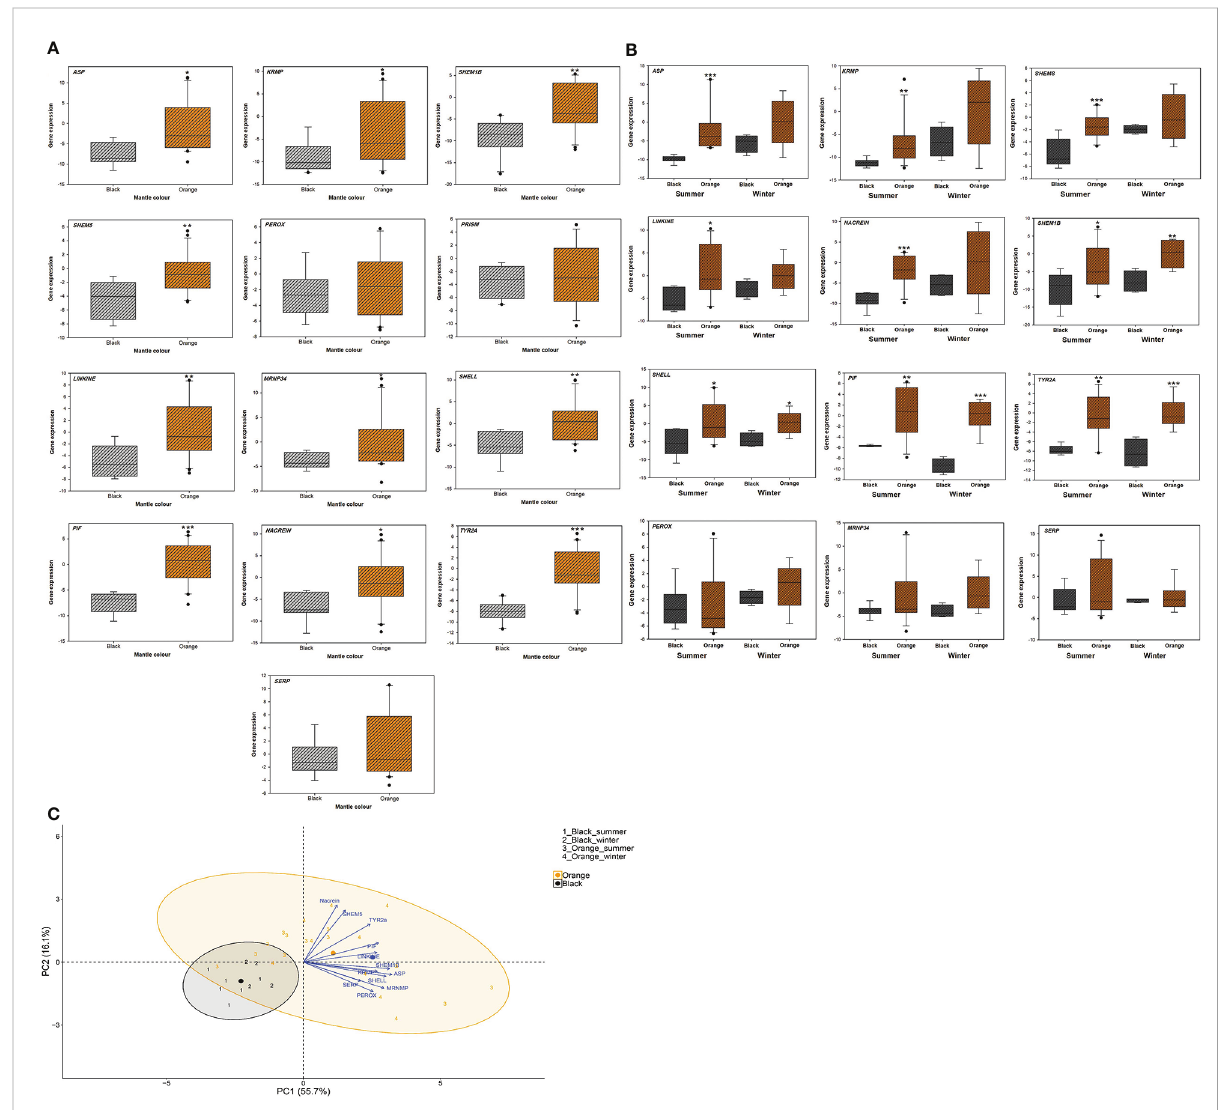
FIGURE 2 (A) The box plots of the expression of genes involved in biomineralization process in orange and black phenotypes of the pearl oyster Pinctada persica. (B) The box plots of the expression of genes involved in biomineralization process in black and orange phenotypes of the pearl oyster Pinctada persica, in winter (cool) and summer (warm) seasons. Grey bars represent data for the black phenotype and orange bars represent data for the orange phenotype. Y axis is in the logarithmic scale (gene expression). Error bars indicate standard deviations. The genes CALM, PEARL and CHIT were only expressed in the orange phenotype. Statistical differences between the phenotypes are indicated by asterisks: *:P<0.05, **: P<0.01, ***:P<0.001. (C) Canonical plots of the fi rst two principal components of the biomineralization genes for two mantle morphs (black and orange) of the pearl oyster Pinctada persica sampled in winter (cool) and summer (warm) seasons. Principal component analysis (PCA) was performed on the entire dataset. Ellipses represent 95% con fi dence areas for the groups within treatments. Centroids are represented by the largest point of the same color. Arrows represent loading vectors of the